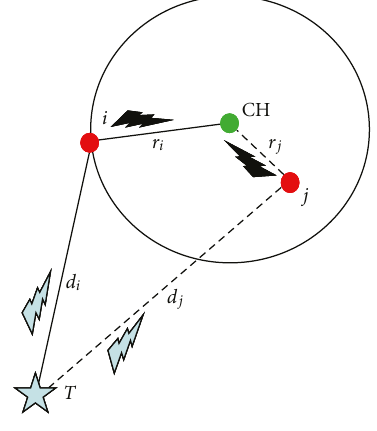
Figure 2: Location discovery